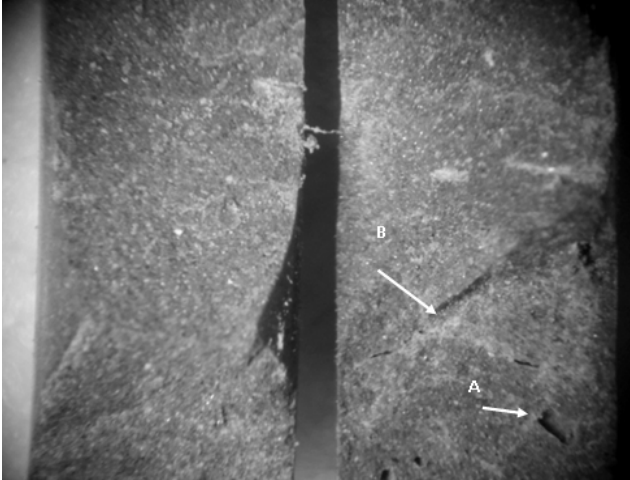
Figure 3: At 10x magni,ication, large internal pores (air -­‐ bubbles) could be seen in cross sections of samples from the indirect u l-­‐ traso n ic activation group (A); Transition areas b e tween ali quots of cement present as “watered -­‐ down, weak fault -­‐